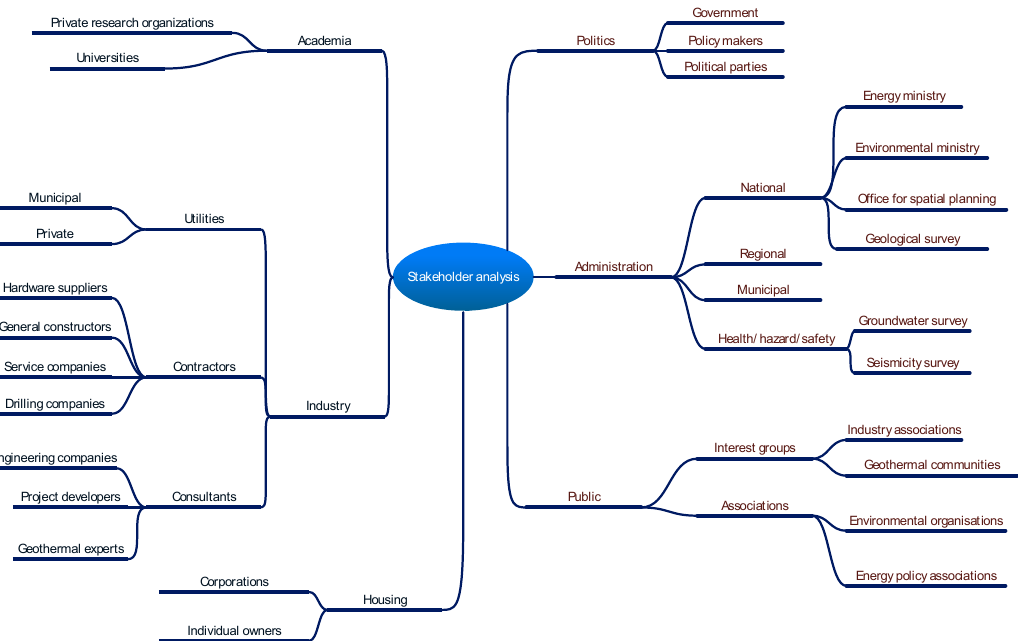
Figure 12. Multi-stakeholder mapping. Based on Minder and Siddiqi [41].